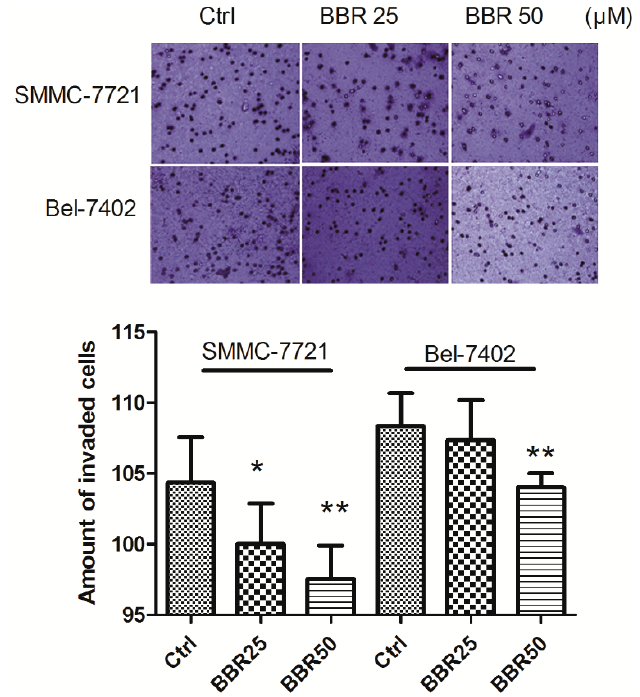
Figure 4. Decreased invasion of BBR-treated HCC cells by transwell test.Matrigel was coated on the transwell membranes. SMMC-7721 and Bel-7402 cells were diluted by 0.2% BSA-containing media in the upper of transwell. Media with BBR (25 and 50 μ M) were added as attractants in the receiver wells. After 24 h, the invasive cells were calculated by violet crystal staining. * p < 0.05 ( vs. the control group); ** p < 0.01( vs. the control group).